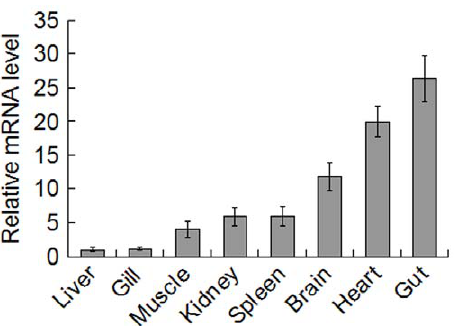
Figure 2. CsISG15 expression in fish tissues. CsISG15 expression in the liver, gill, muscle, kidney, spleen, brain, heart, and gut of tongue sole was determined by quantitative real time RT-PCR. The expression level in liver was set as 1. Five animals were used at each time point, and for each time point the PCR was performed three times. The results are shown as means 6 SE (N=5).